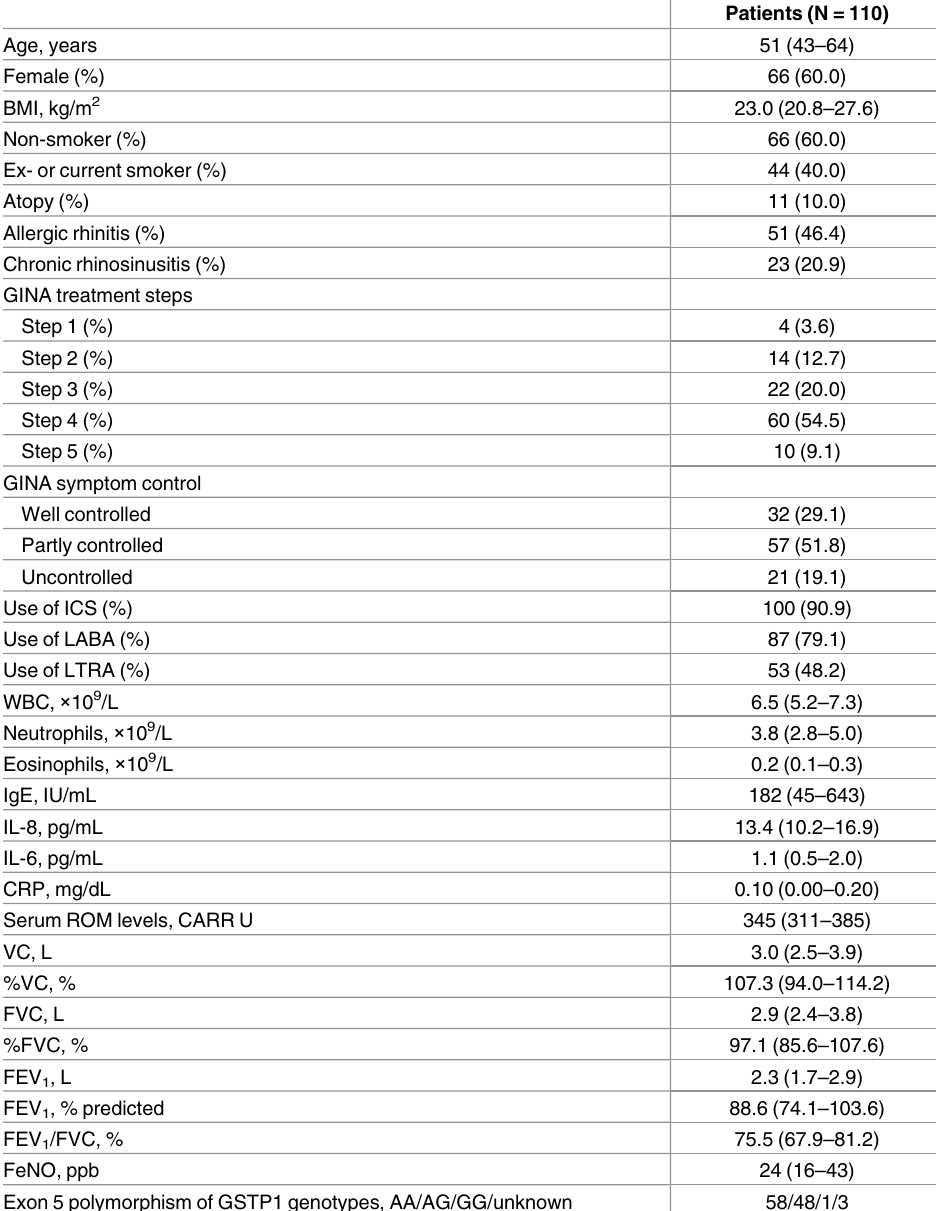
Table 1. Patient